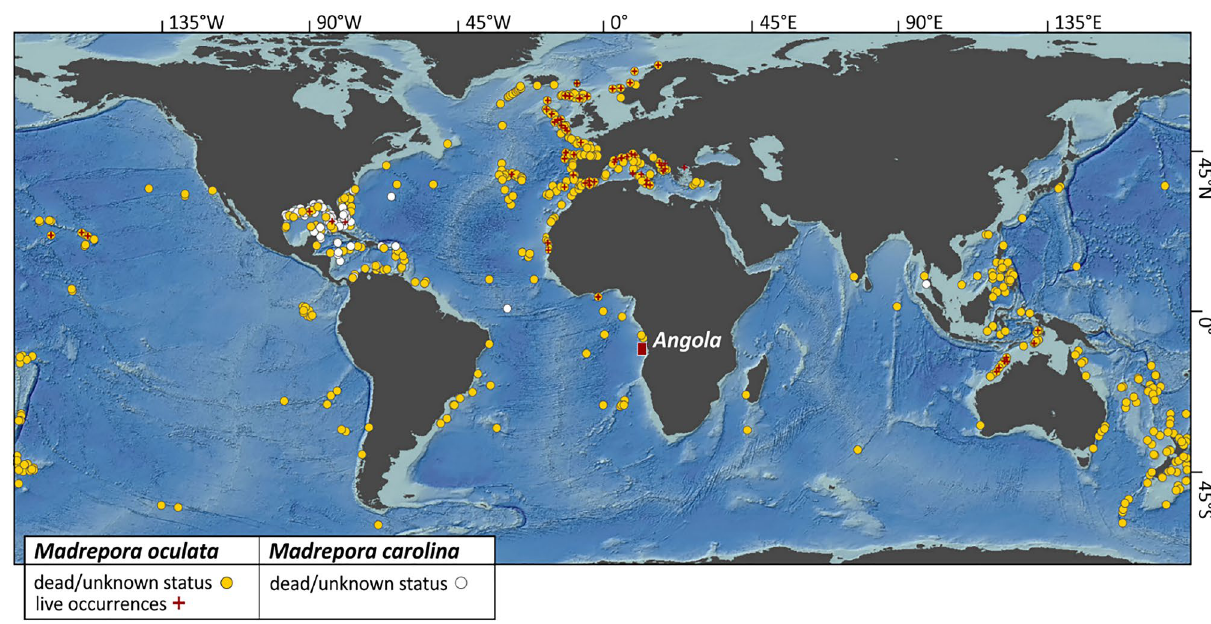
Figure 1. Geographical distribution of Madrepora oculata and Madrepora carolina . The global map shows the distribution of the two reef-forming species of the genus Madrepora (sources: World Conservation Monitoring Centre of the United Nation Environmental Programme, UNEP-WCMC; Ocean Biogeographic Information System, OBIS). While a large number of records of M. oculata (yellow dots; live occurrences indicated by a red cross) is reported in the North Atlantic and the West and South Pacific, M. carolina (white dots) is endemic to the NW Atlantic. The red polygon highlights the study area off Angola in the SW Atlantic, where living com/ clean topo2) and was created with ESRI ArcGIS Desktop